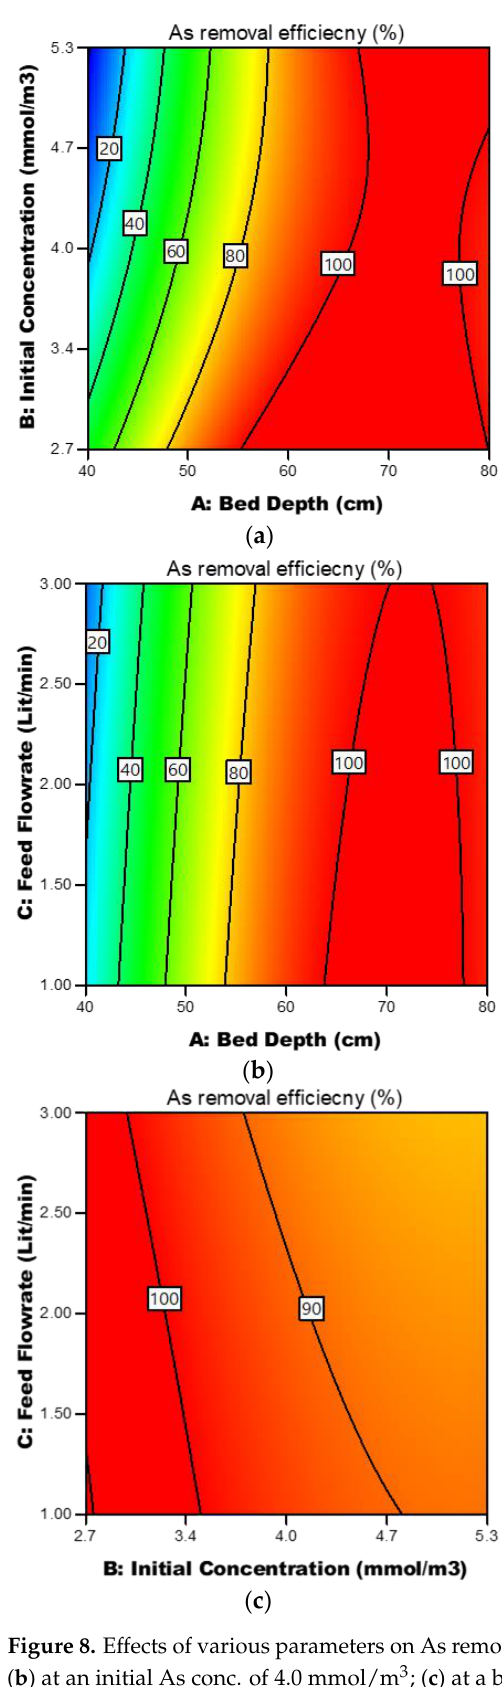
Figure 8. Effects of various parameters on As removal efficiency R1: ( a ) at a feed flow rate of 2 L/min;